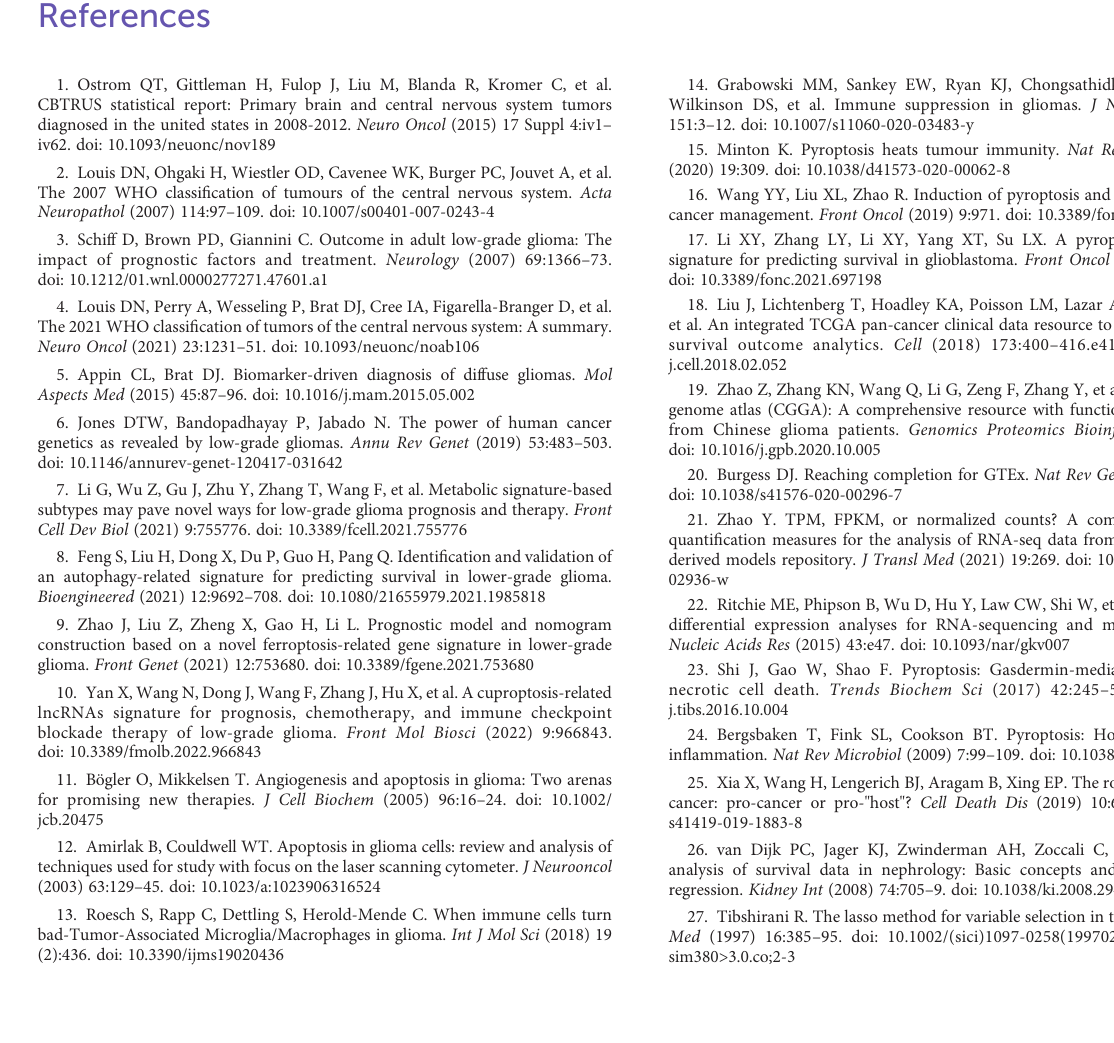
expression level, and red represents a high expression level. (B) Pearson correlation analysis of the 33 pyroptosis-related genes in LGGs. Red indicates the degree of positive correlation, and blue indicates the degree of negative correlation. SUPPLEMENTARY FIGURE 2 Analysis of clinical factors in subgroups. (A) Univariate analysis and multivariate analysis for hazard ratio values of risk score and clinical characters in the training set (CI, con fi dence interval). (B-C) Relationship between prognostic gene expression and clinical factors. Green represents a low expression level, and red represents a high expression level. SUPPLEMENTARY FIGURE 3 Comparison of ssGSEA scores in high- and low-risk groups. (A) Training set. (B) Testing set. The green box shows the low-risk group, and the red box shows the high-risk group. ∗ P< 0.05; ∗∗ P< 0.01; ∗∗∗ P< 0.001; ns: not signi fi cant. SUPPLEMENTARY FIGURE 4 Association between the abundance of immune cells and the expression in LGGs. (A) CASP3. (B) CASP4. (C) CASP8. (D) CASP9. (E) GSDMC. (F)